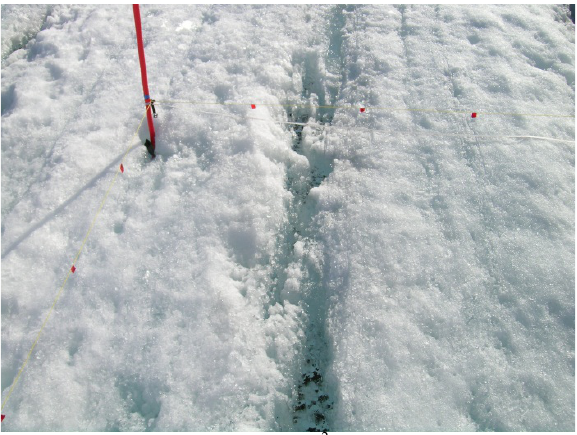
Figure 3. One of the 1 m 2 area photographs